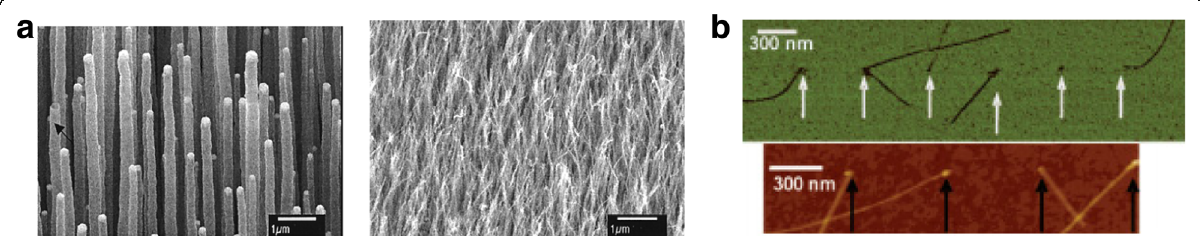
Fig. 17 CVD based growth of CNTs produced using different diameter nanoparticle catalyst. a SEM images of CNTs produced with different diameters (250 nm and 20 nm in diameter) using nickel-coated glass substrates. Adapted from [149]. b AFM images of nanotubes grown using lithographically patterned catalyst and Co nanoparticles with a diameter of ∼ 1.7 nm. Adapted from